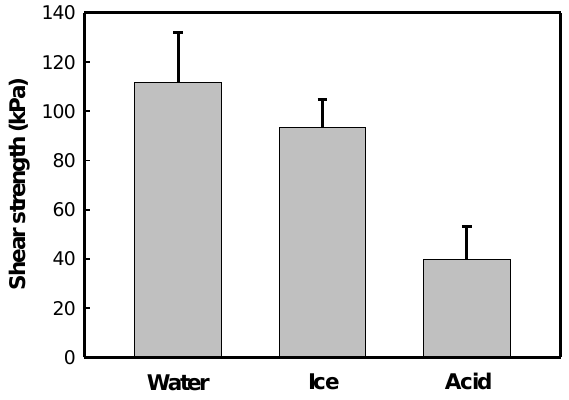
Figure 6. Direct shear strengths ( τ , kPa) of treated sands with Sporosarcina ureae in flood (water), freeze–thaw (ice) and acid rain (acid) simulations (SE, n =